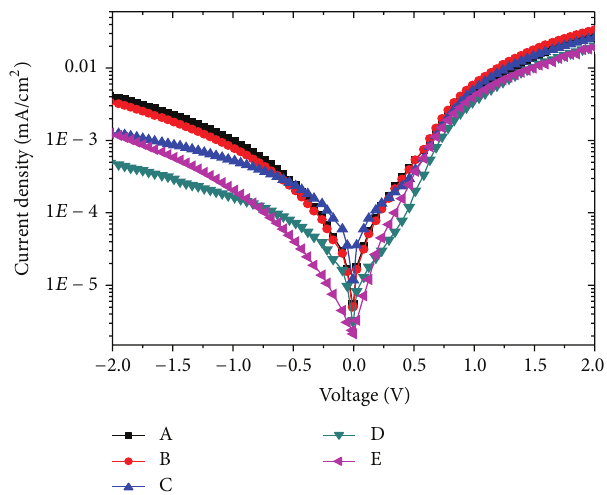
Figure 4: J - V curve of device under dark condition. A: only PEDOT:PSS solution on ITO at the speed of 3000 rpm. B: the PEDOT:PSS and DMAC mixed in a ratio of 4: 1(v/v) at the speed of 3000 rpm. C, D, and E: the PEDOT:PSS buffer layer modified by DMAC at speed of 1000, 3000, and 5000